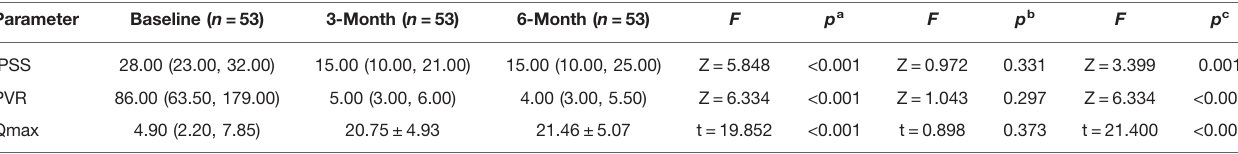
TABLE 2 | Data at baseline and 3- and 6-month after surgery.